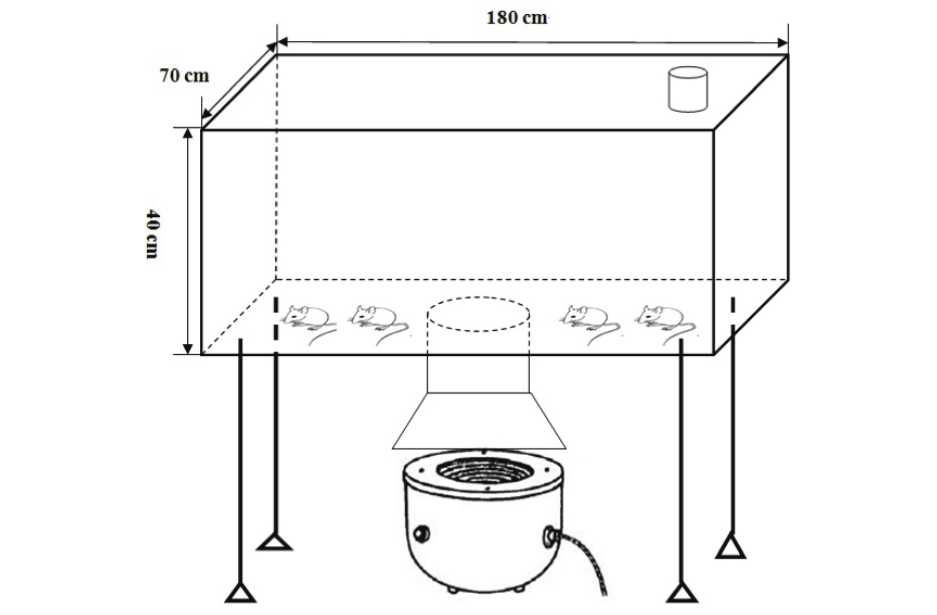
Figure 1. The designed pulmonary airway